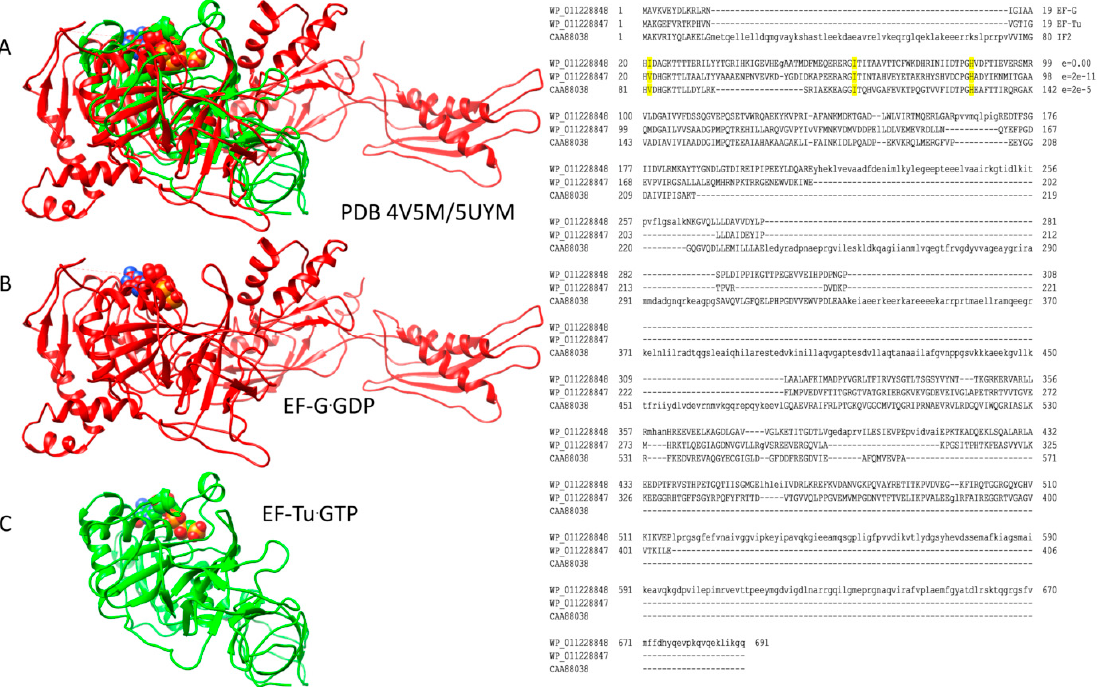
Figure 4. EF-Tu and EF-G are homologs that occupy the same site on the ribosome; ( A ) overlay of ribosome-EF-Tu · GTP (green; PDB 5UYM) and ribosome-EF-G · GDP (red; PDB 4V5M). Overlays were done for ribosomal protein S2. Ribosomes are omitted from the images for simplicity; ( B ) EF-G · GDP structure (red); ( C ) EF-Tu · GTP structure (green). At the right, an alignment of Thermus thermophilus EF-G, EF-Tu, and IF2 is shown. Conserved residues (i.e., EF-Tu, Val21, Ile61, and His86) involved in stimulating GTP hydrolysis are indicated. In the alignment, e-values are versus Escherichia coli EF-G.